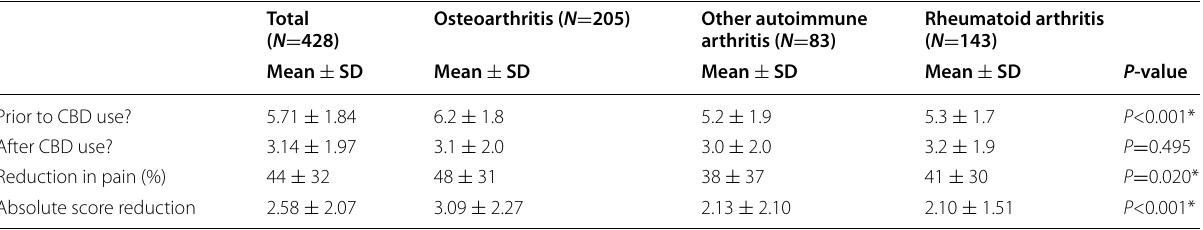
Comparative statistics performed with Kruskal-Wallis based on diagnosis